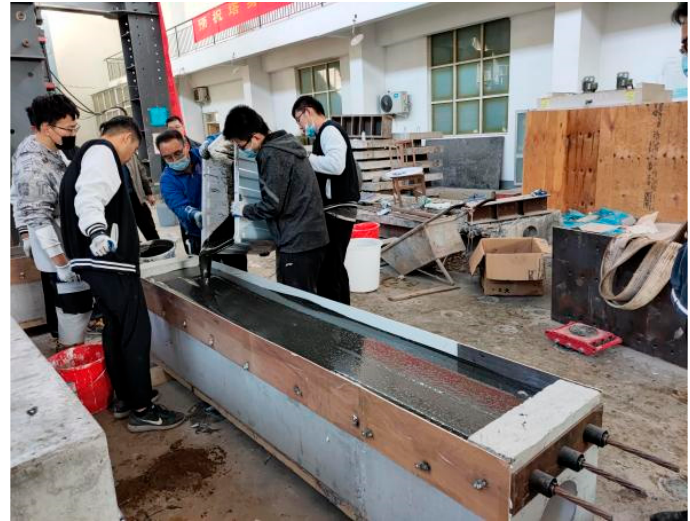
Figure 5. Field photograph of steel strands: ( a ) tensioning, ( b ) anchorage.